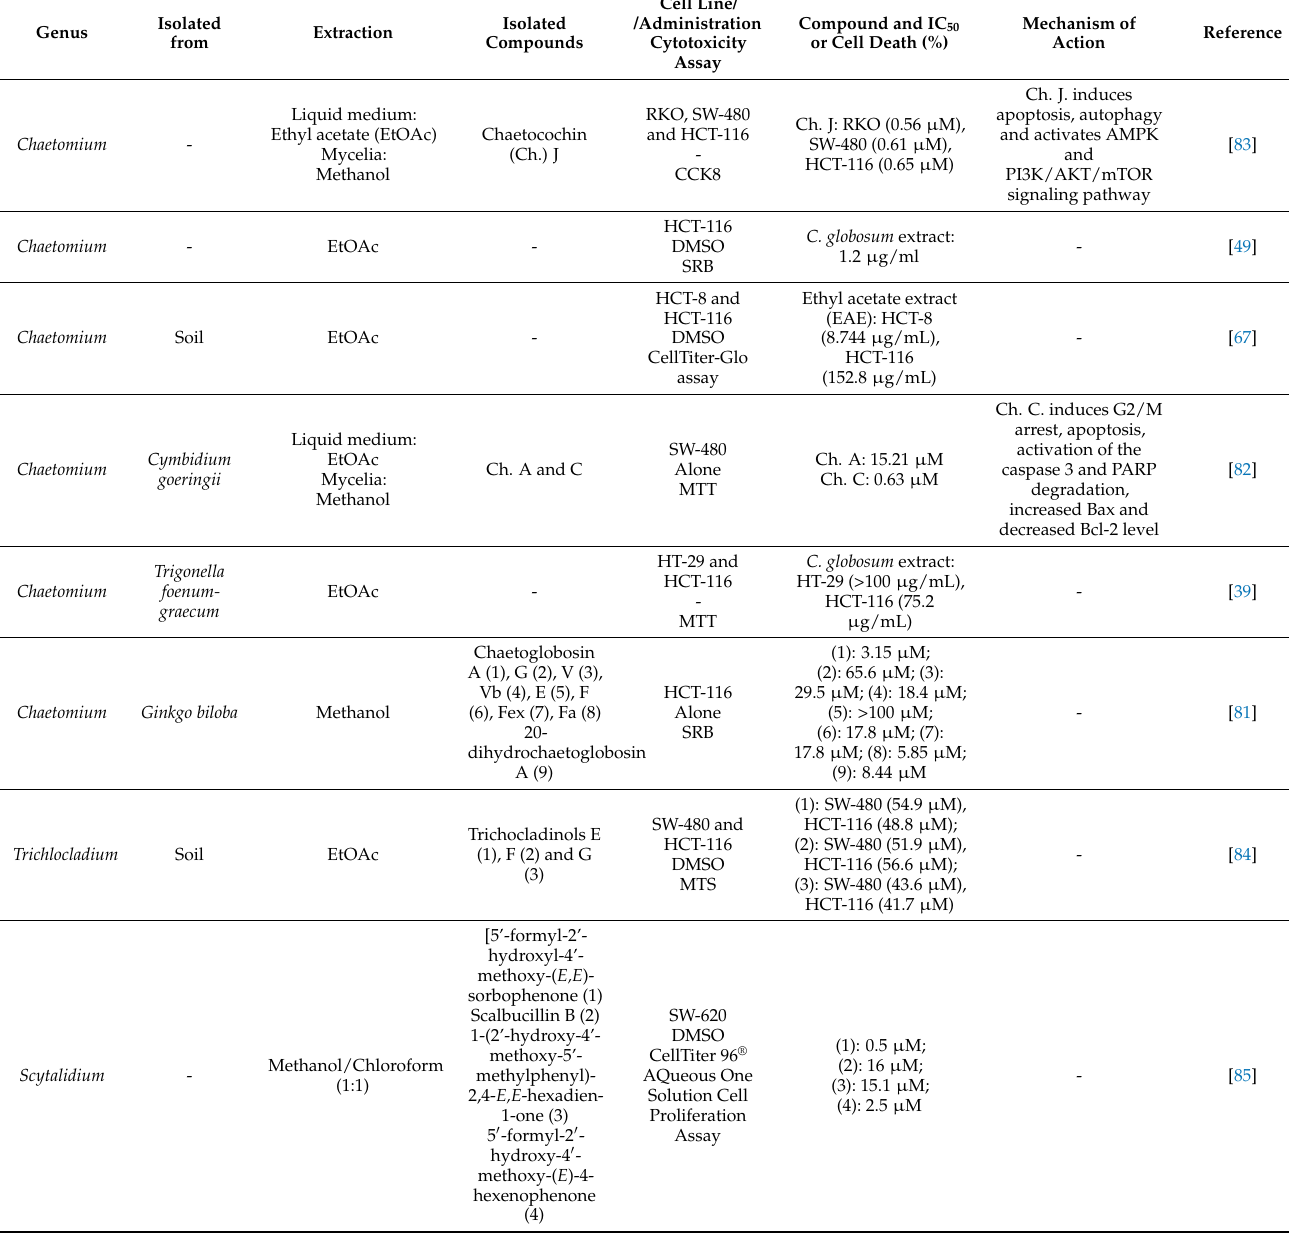
Table 4. Antitumor activity of the extracts or isolated compounds from Sordariales order in CRC cancer cell